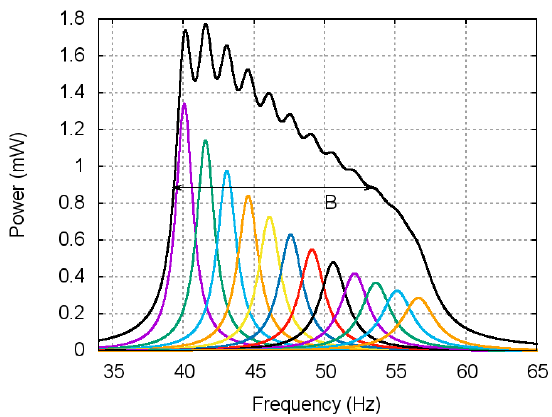
Figure 7. Simulation of a cantilever beam array with 12 cantilevers and ∆ f = 1.5 Hz.